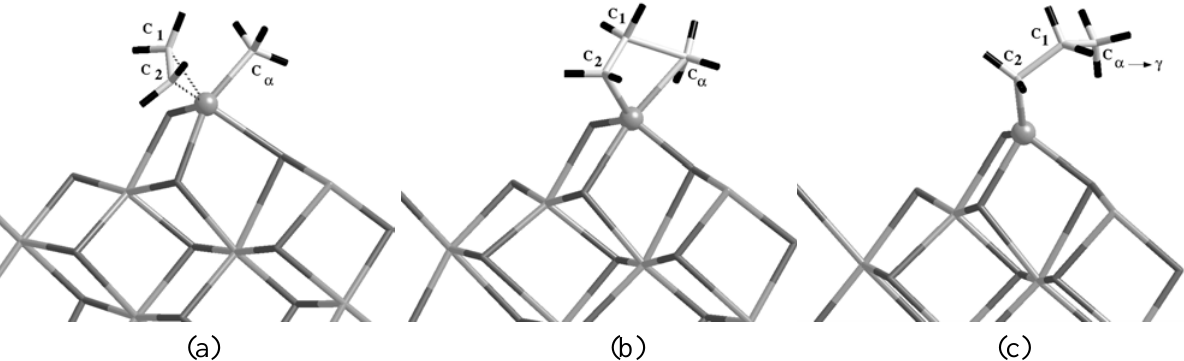
molecule on the MgCl (110) surface 3 2